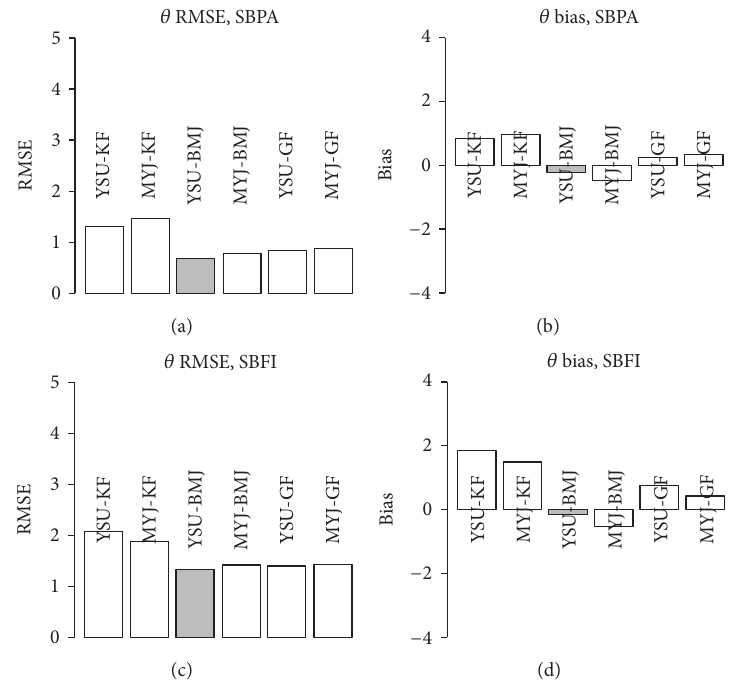
Figure 12: As in Figure 8 but for the simulations evaluated at 12Z 18 January 2010.